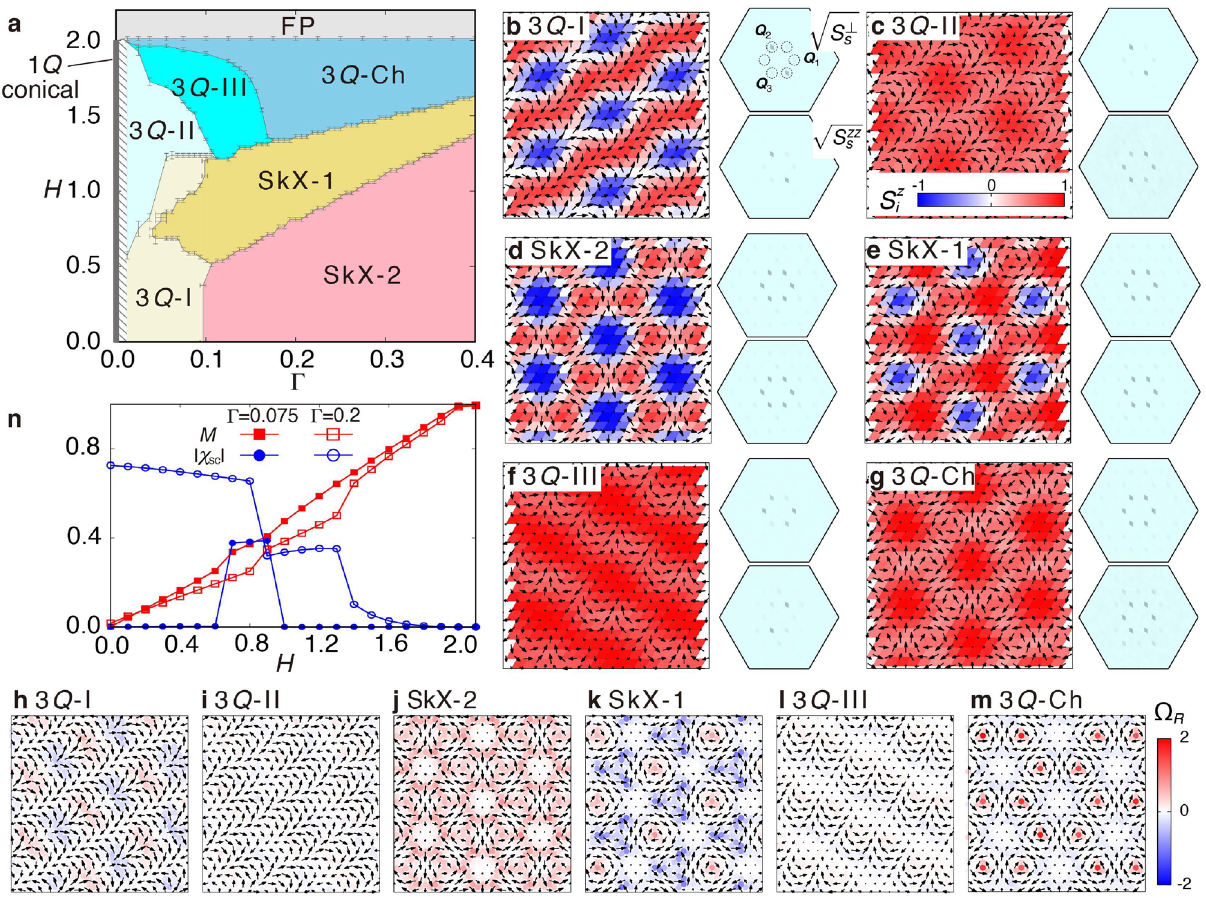
Figure 2. Magnetic phase diagram and characteristics of magnetic phases. ( a ) Ŵ - H magnetic phase diagram for the model in Eq. (6) in the unit of J . The 3 Q -I, 3 Q -II, 3 Q -III, SkX-2, SkX-1, 3 Q -Ch, 1 Q conical, and FP 2 SkX, n sk 1 T-SkX, triple- Q chiral, single- Q conical, represent the triple- Q I, triple- Q II, triple- Q III, n sk = = and fully polarized states, respectively. In the hatched region, energies for several magnetic states are degenerate and it is difficult to determine the phase boundaries. ( b – g ) Snapshots of the spin configurations in ( b ) 3 Q -I for 0.075 and H 0.4 , ( c ) 3 Q -II for Ŵ 0.075 and H 1.3 , ( d ) SkX-2 for Ŵ 0.2 and H 0 , ( e ) SkX-1 for Ŵ = = = = = = 0.2 and H 0.075 and H 1.6 , and ( g ) 3 Q -Ch for Ŵ 0.2 and H 1.4 . The arrows 1 , ( f ) 3 Q -III for Ŵ Ŵ = = = = = = and contour denote the xy and z components of the spin moments, respectively. The square root of in-plane and out-of-plane spin structure factors in the Brillouin zone are shown in upper and lower panels, respectively, 0 component is removed for better visibility. Q 3 and the q Q 1 , Q 2 , and where the dashed circles highlight = ± ± ± ( h – m ) Real-space distributions of the skyrmion density (cid:31) R for the spin configurations in ( b – g ), respectively. 0.075 (filled ( n ) H dependences of the magnetization (red square) and spin scalar chirality (blue circle) for Ŵ = 0.2 (open symbols) and Ŵ =